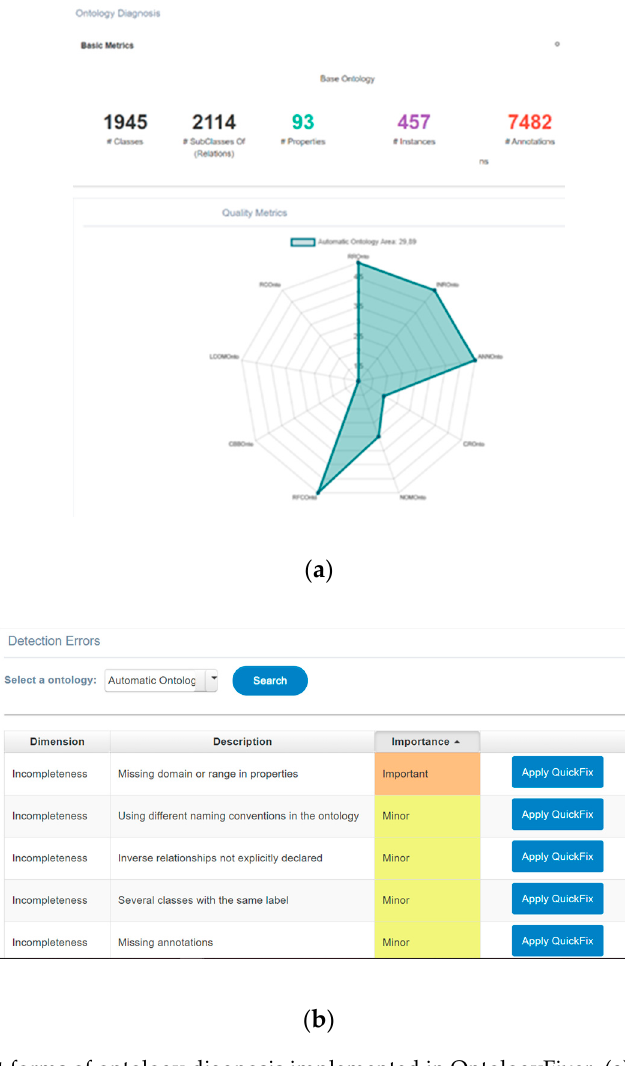
Figure 8. Di ff erent forms of ontology diagnosis implemented in OntologyFixer. ( a ) Quality evaluation. Figure 8. Different forms of ontology diagnosis implemented in OntologyFixer. ( a ) Quality ( b ) Errors and smells evaluation. ( b ) Errors and smells detection.